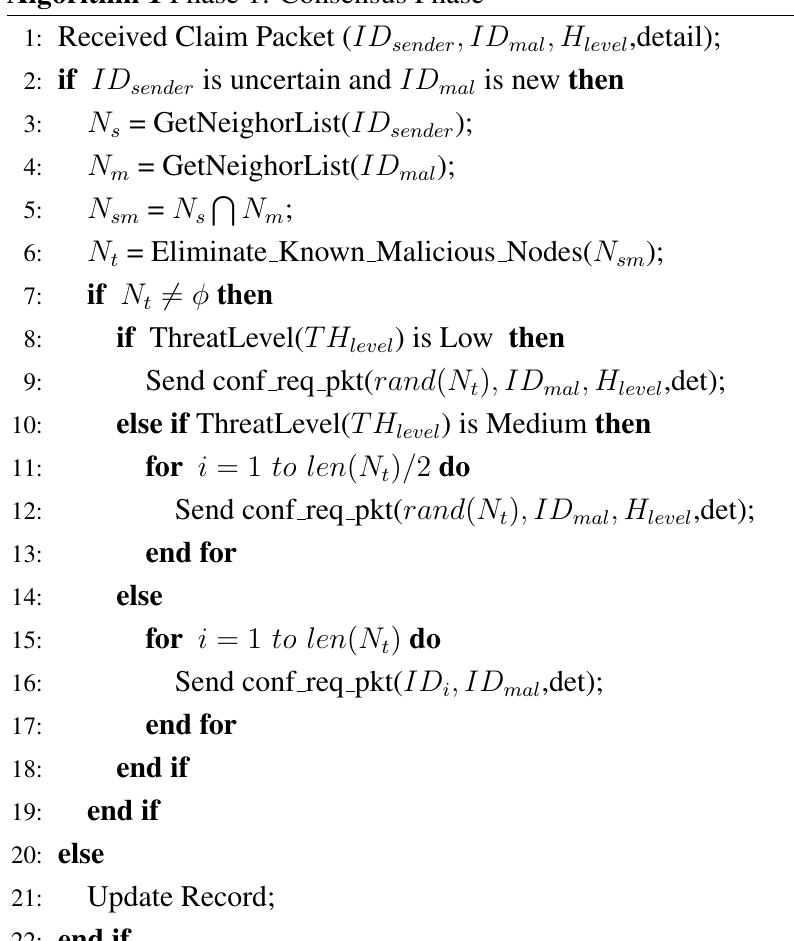
Algorithm 1 Phase 1: Consensus